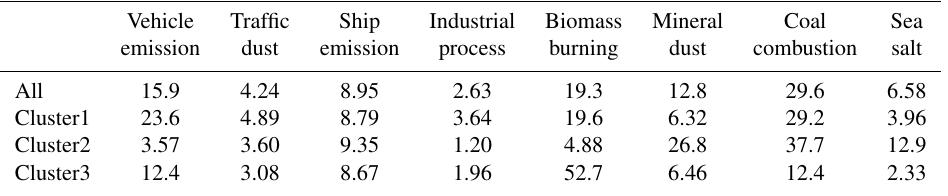
Table 3. Averages of fractional contributions (%) from eight sources identified by PMF model. Vehicle Traffic Ship Industrial Biomass Mineral Coal Sea emission dust emission process burning dust combustion salt